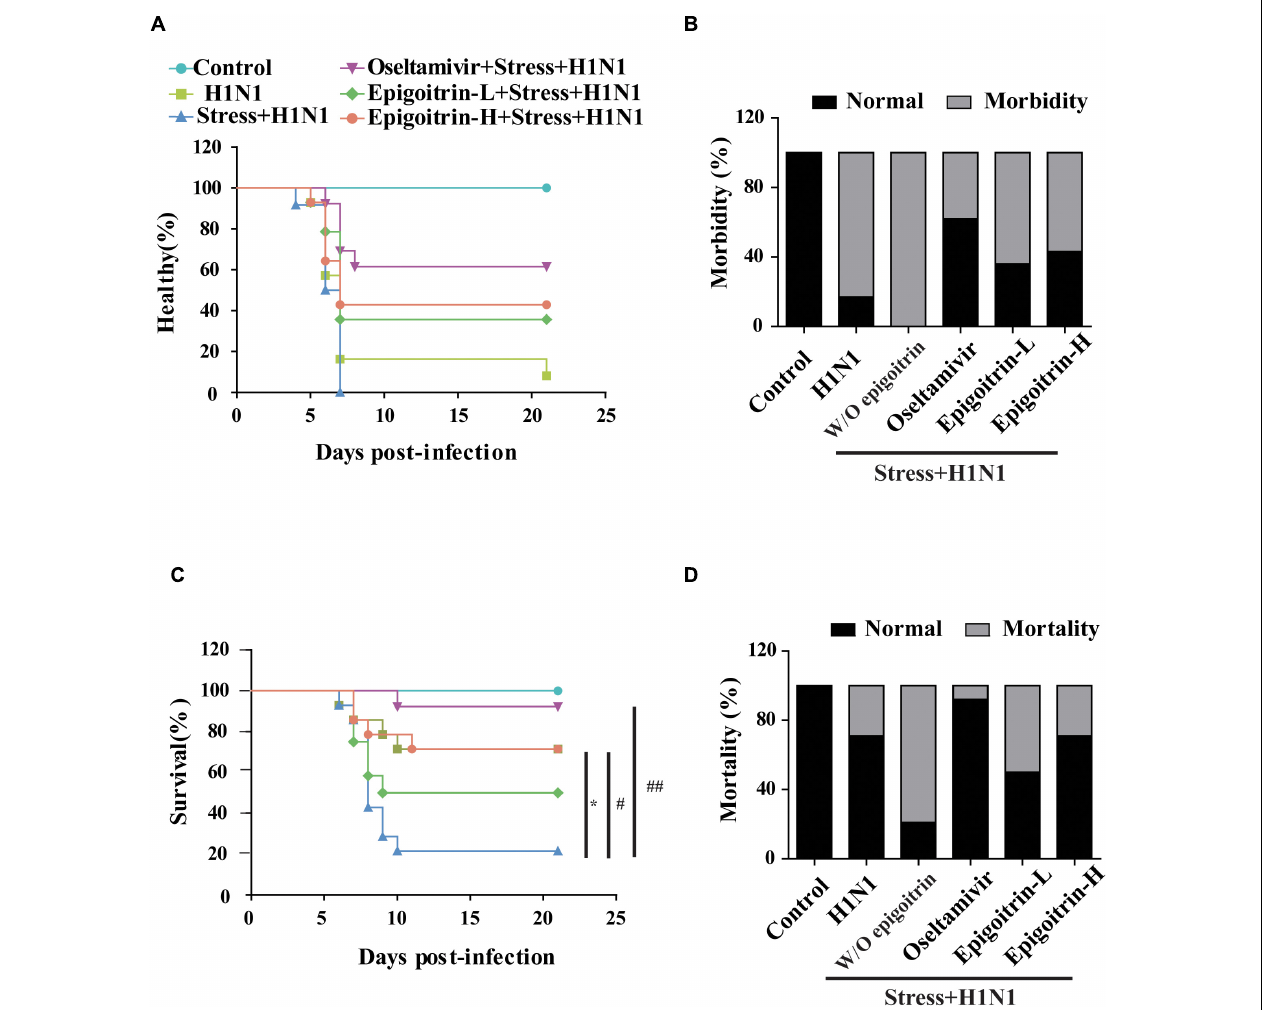
FIGURE 1 | Epigoitrin attenuated the morbidity and mortality caused by influenza infection in stressed mice. (A,B) Healthy curve and morbidity caused by influenza infection in restraint mice. (C,D) Survival curve and mortality caused by influenza infection in restraint mice. “W/O epigoitrin” indicates without epigoitrin treatment. Epigoitrin-H and Epigoitrin-L, respectively, represent the higher dose of epigoitrin (176 mg/kg/d) and the lower dose of epigoitrin (88 mg/kg/d). The difference was considered statistically significant at ∗ P < 0.05 vs. H1N1 group; # P < 0.05 and ## P < 0.01 vs. “Stress+H1N1” group. Data were obtained from 10–14 animals in each